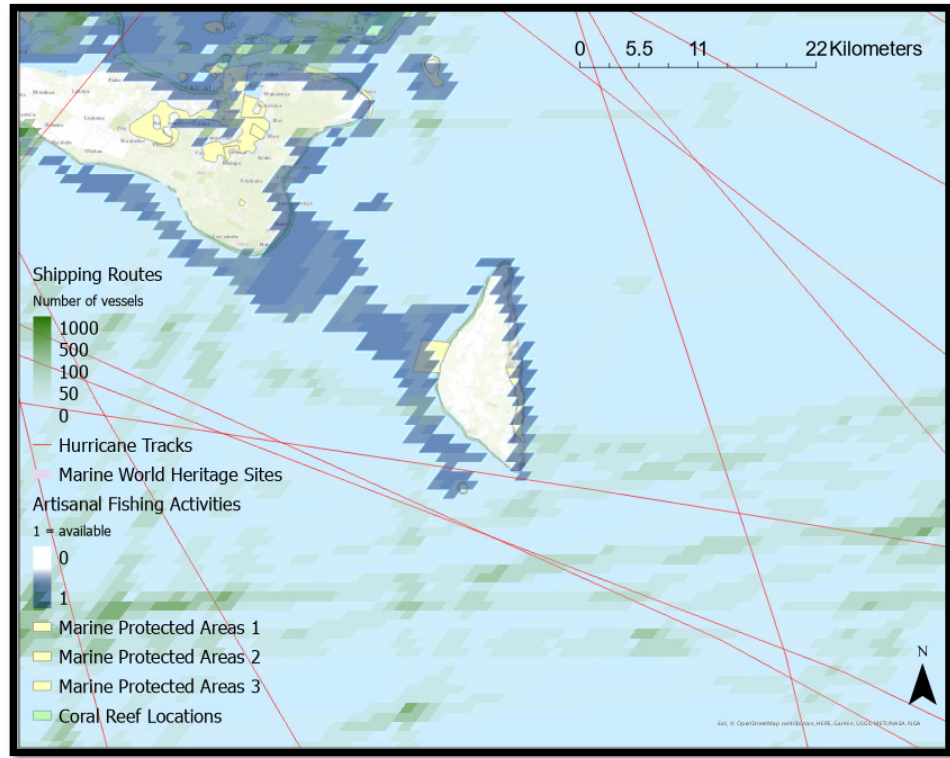
Figure 7. Map for ‘Eua demonstrating challenges found through spatial analysis. Color layers as per explained in Figure 4’s caption.